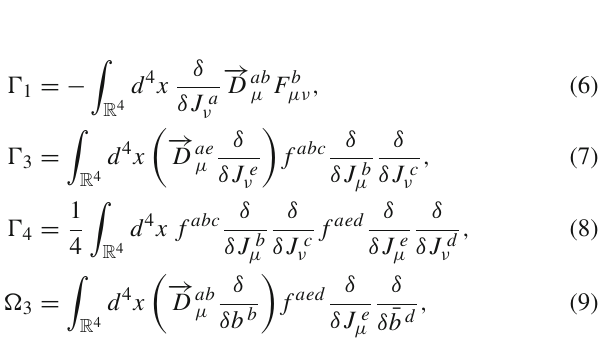
and vertex operators with functional